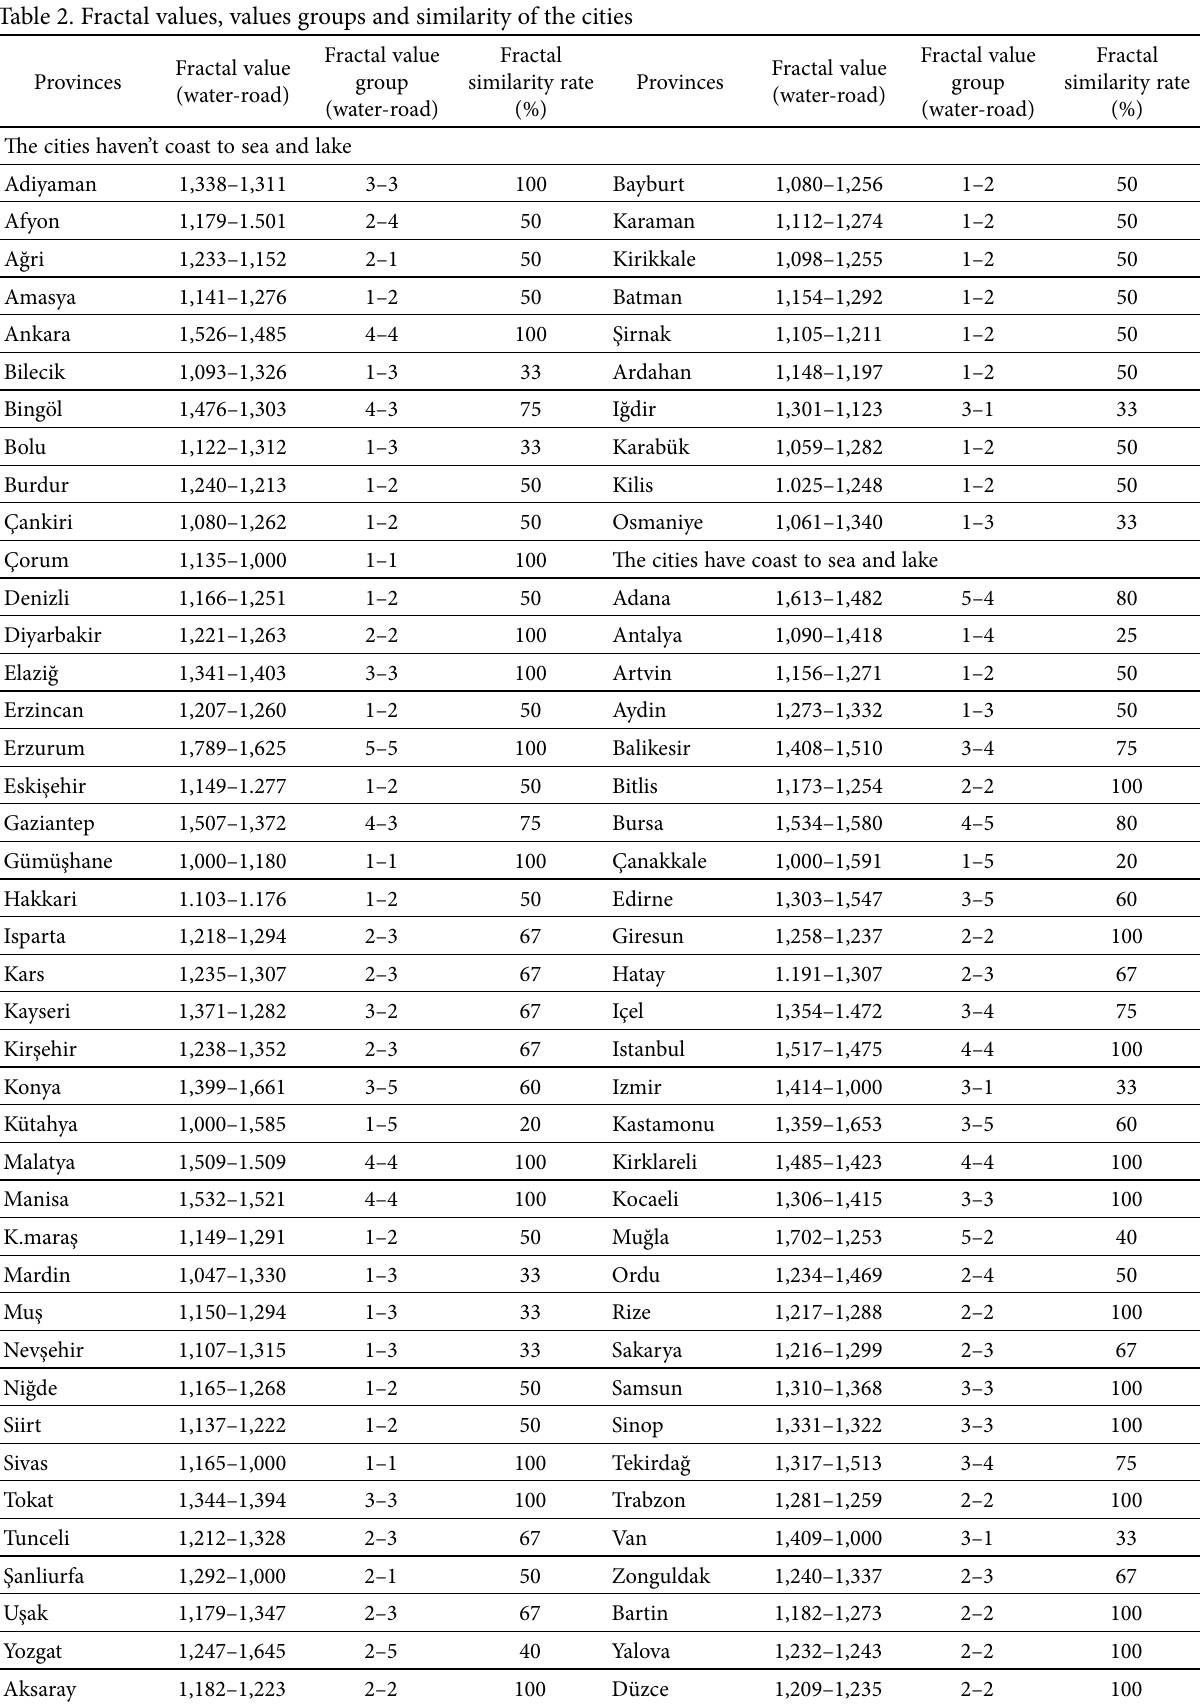
Table 2. Fractal values, values groups and similarity of the cities